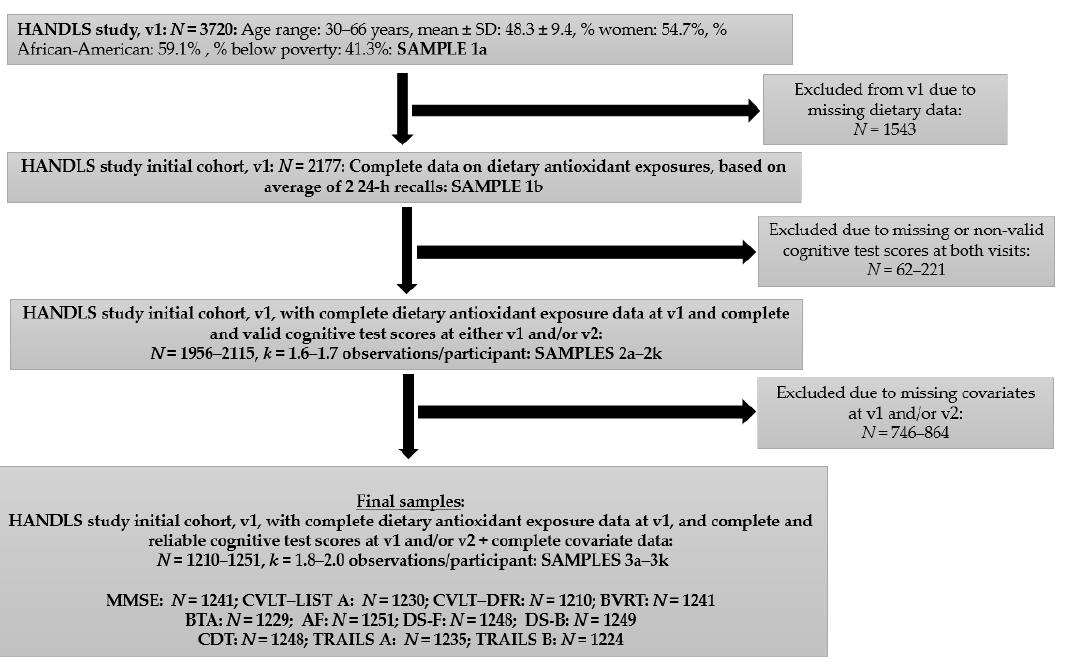
Figure 1. Participant flowchart. Abbreviations: AF = Animal Fluency; BTA = Brief Test of Attention; BVRT = Benton Visual Retention Test; CDT = Clock Drawing Test; CVLT ‐ DFR = California Verbal Learning Test ‐ Delayed Free Recall; CVLT ‐ List A = California Verbal Learning Test ‐ List A; DS ‐ B = Digits Span ‐ Backward; DS ‐ F = Digits Span ‐ Forward; HANDLS = Healthy Aging in Neighborhood of Diversity across the Lifespan; k = mean; MMSE = Mini ‐ Mental State Examination; N = Number of participants; TRAILS A = Trailmaking Test, part A; TRAILS B = Trailmaking Test, part B.